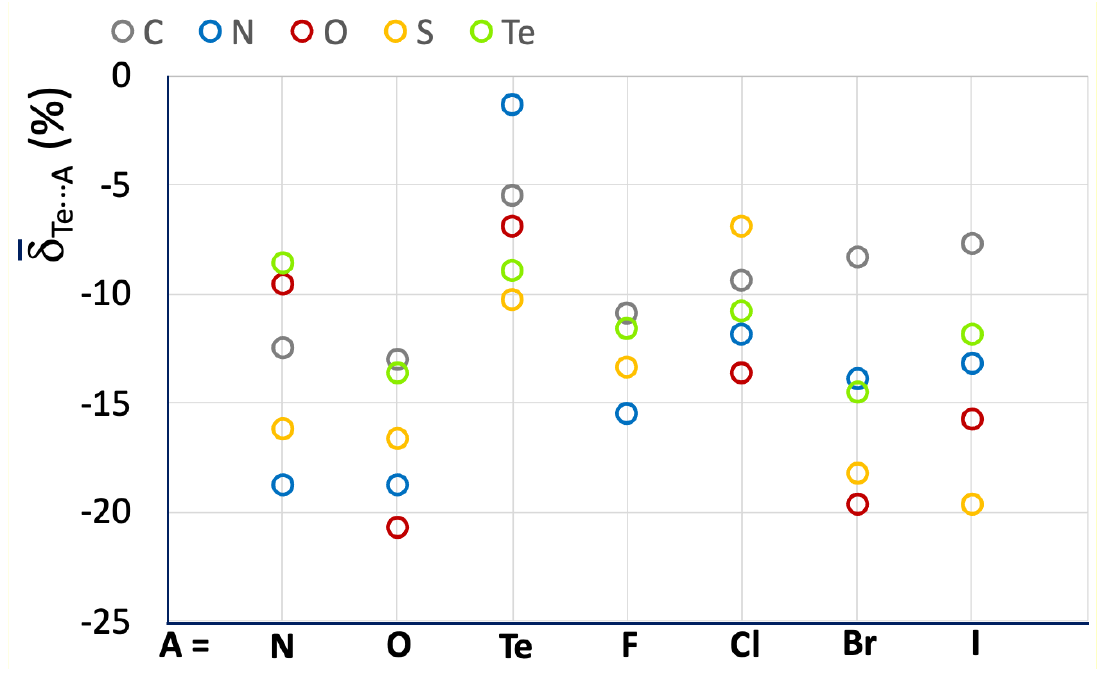
Figure 10. Mean δ Te ··· A values calculated for the R–Te · · · A fragments. A = N, O, Te, F, Cl, Br, and I; Figure 10. Mean δ̅ Te···A values calculated for the R – Te···A fragments. A = N, O, Te, F, Cl, Br, and I; R R = C (grey), N (blue), O (red), S (yellow), and Te (acid = C (grey), N (blue), O (red), S (yellow), Se (magenta), and Te (acid green).